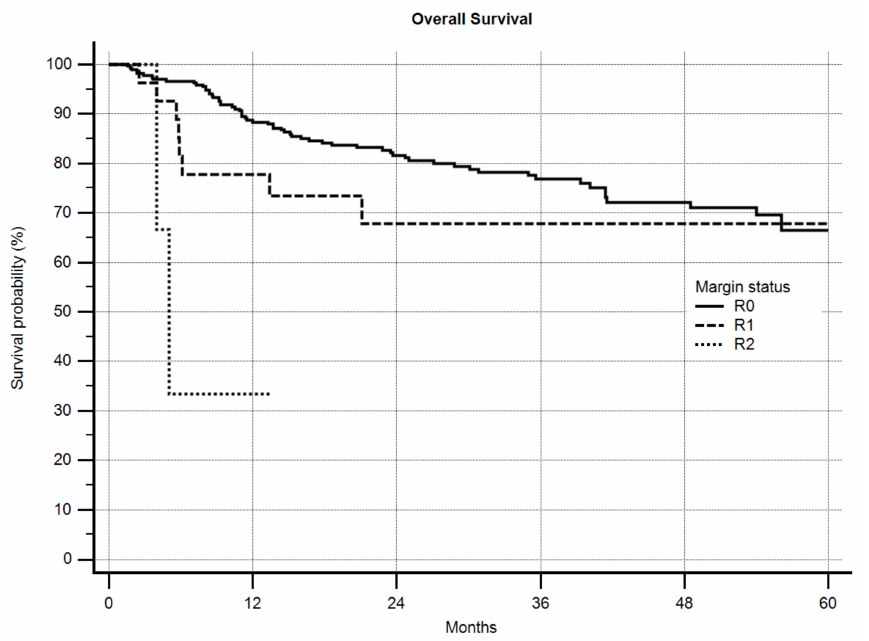
Figure 3. Overall survival by local recurrence, n = 305, p =